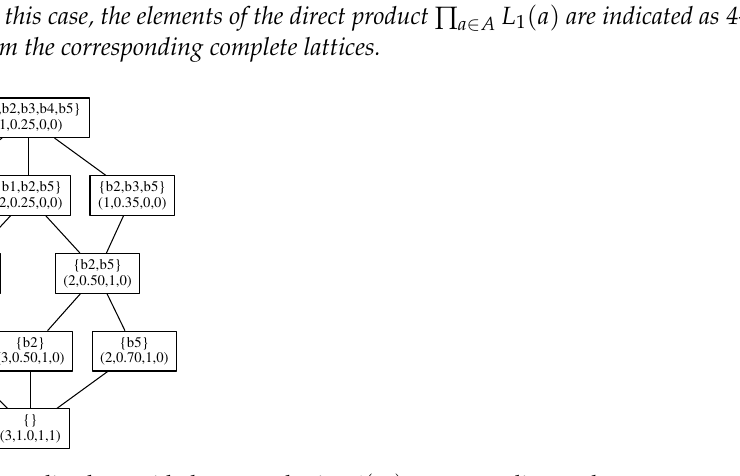
Figure 1. Generalized one-sided concept lattice C ( c 1 ) corresponding to the context c 1